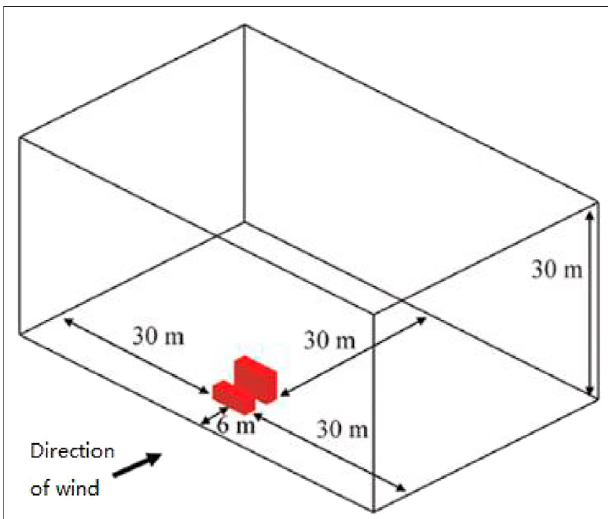
FIGURE 1 | Diagram of the computational domain.